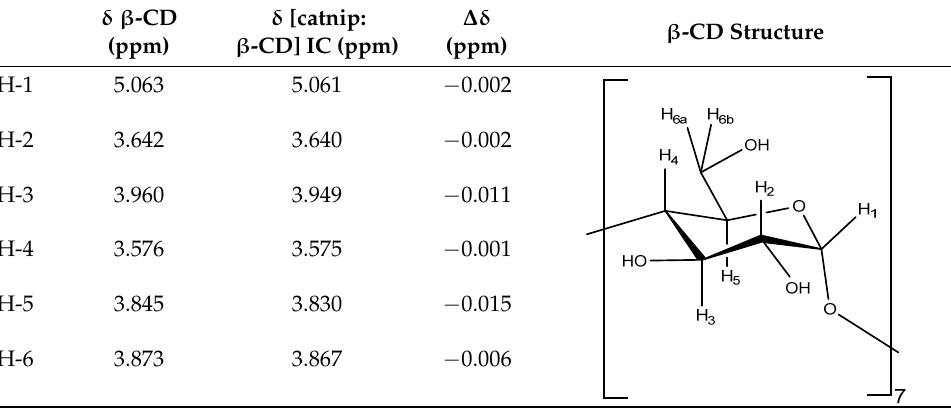
Figure 4. UV-Vis spectra of catnip essential oil (EO), β -cyclodextrin ( β -CD), their inclusion com- plexes (IC), and their physical